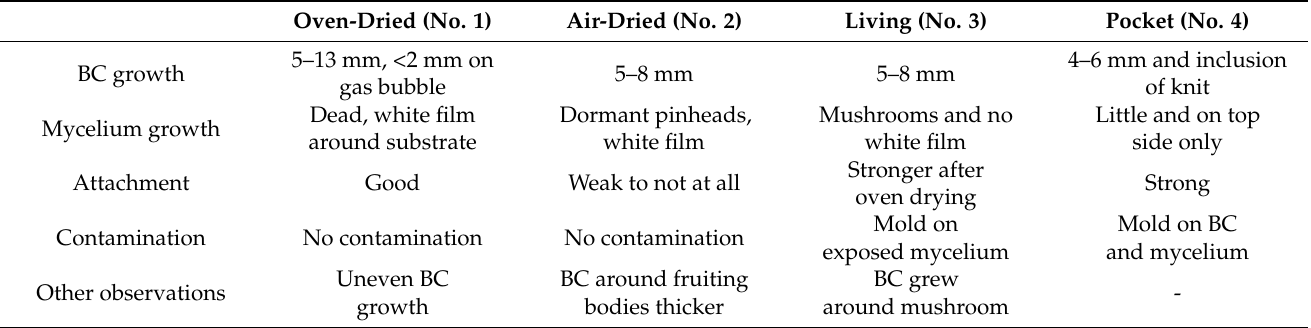
Table 1. The summary of the experiment.